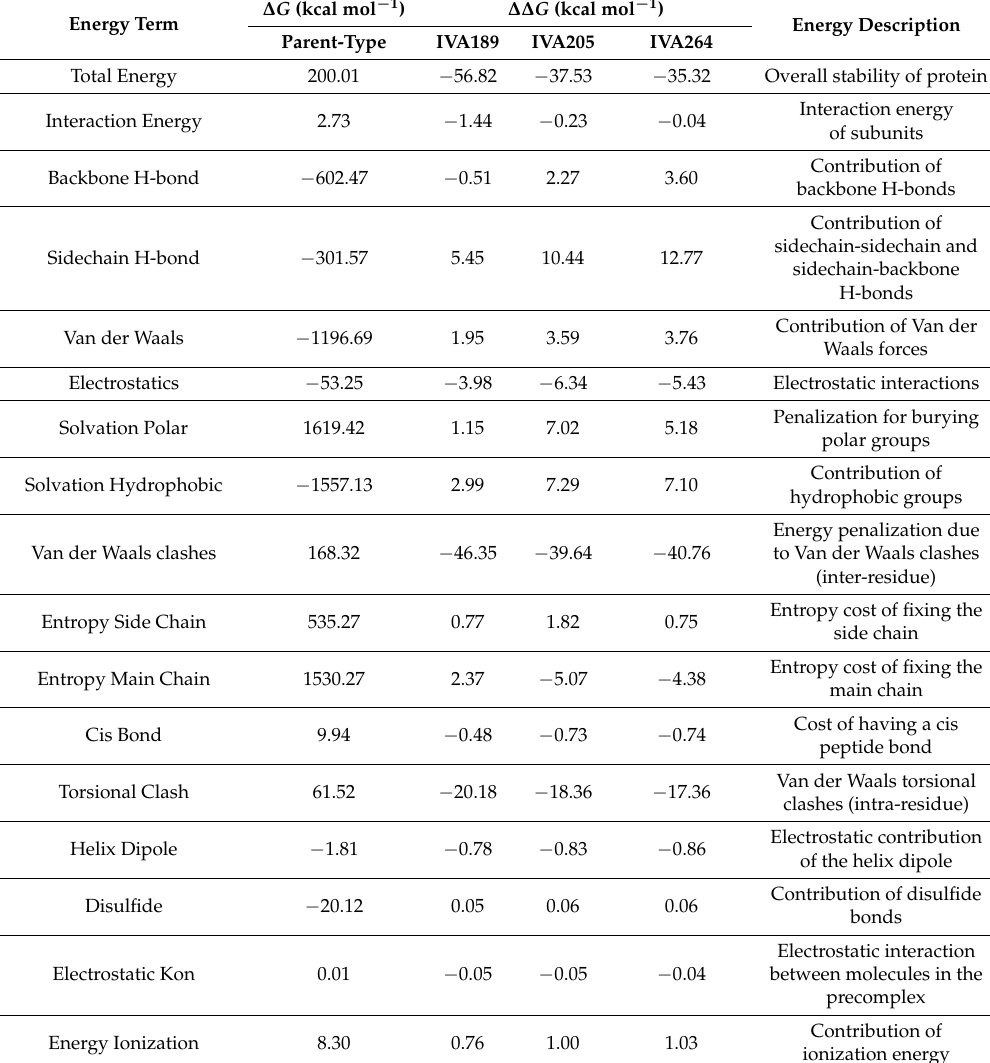
Table 3. Computed free energies of folding and energy components ( ∆ G ) of the parent laccase and the relative free energies of folding ( ∆∆ G ) of the evolved